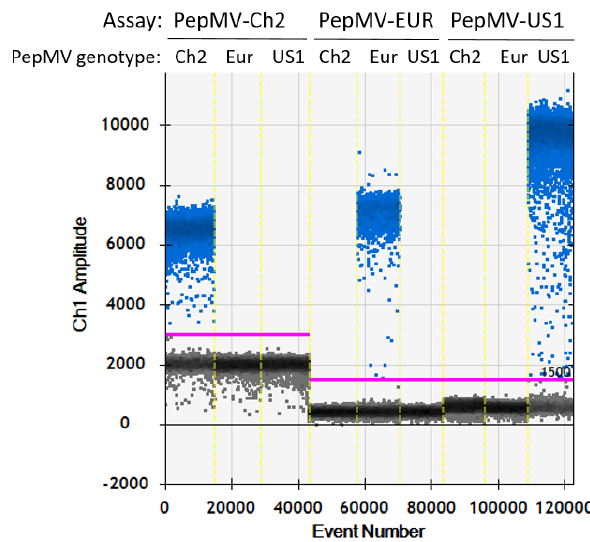
Figure 1. Specificity of the RT-dPCR assays tested on the QX100/200 platform. Specificity